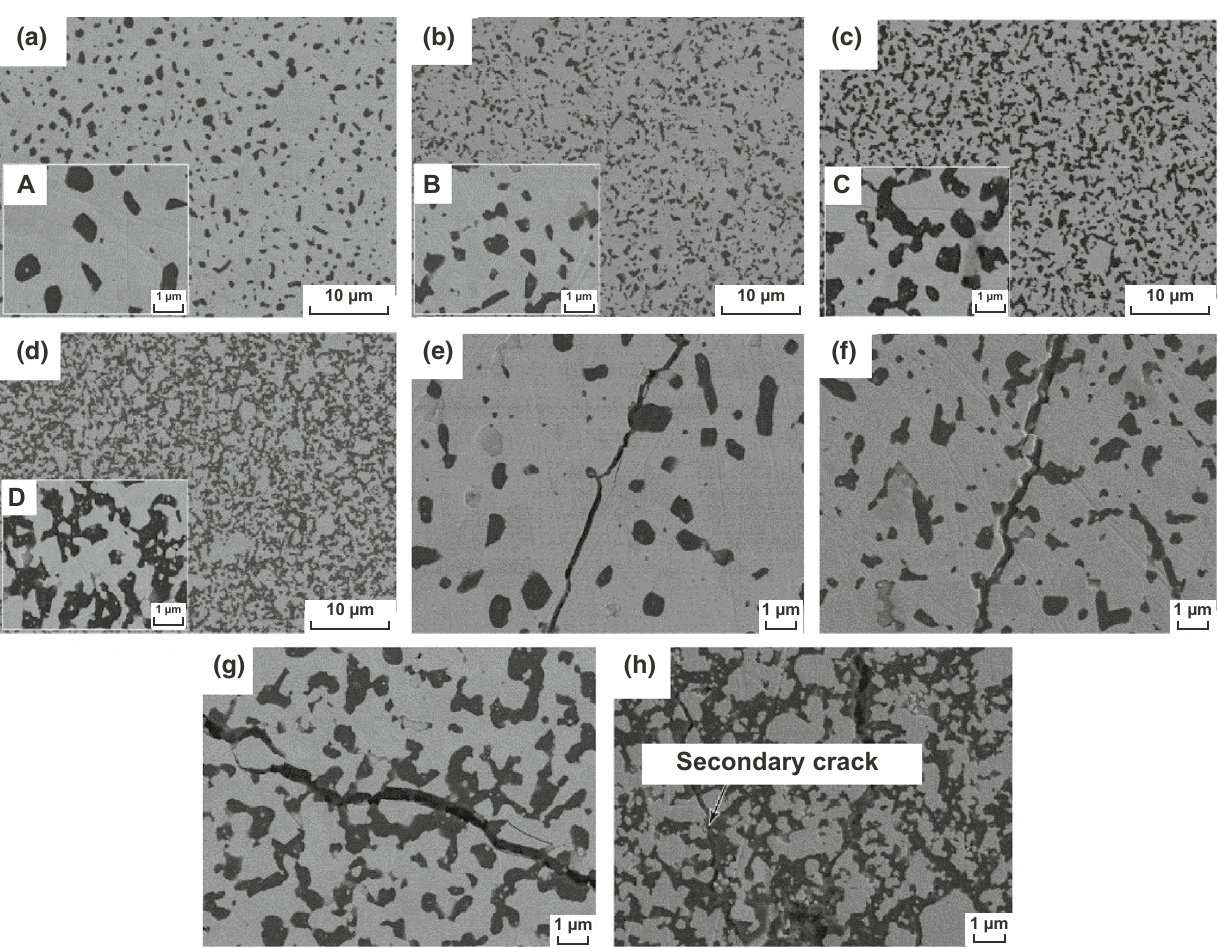
Fig. 9 FE‑SEM images of the polished samples showing the different dispersion states and morphologies of the toughening particulates: ( a, A ) WC–10 vol% Al 2 O 3 , ( b, B ) WC–20 vol% Al 2 O 3 , (c, C ) WC–30 vol% Al 2 O 3 , and (d, D ) WC–40 vol% Al 2 O 3 , composites sintered at 1540 °C for 90 min. FE‑SEM images of Vickers indentation crack extension path of e WC–10 vol% Al 2 O 3 , f WC–20 vol% Al 2 O 3 , g WC–30 vol% Al 2 O 3 , and